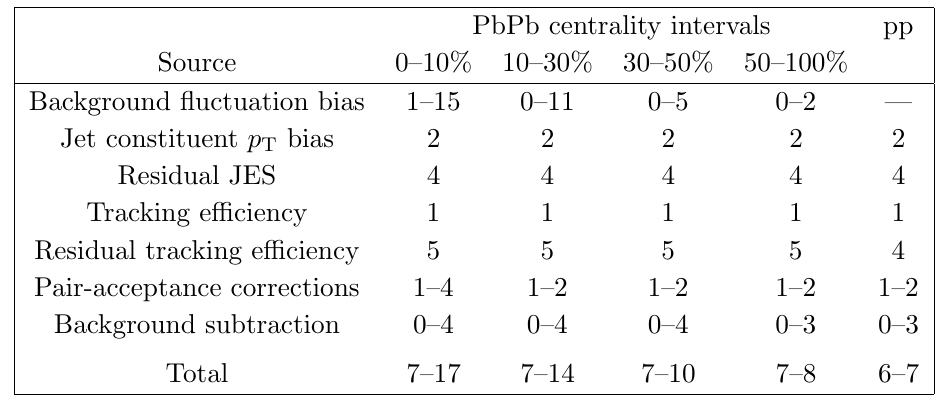
Table 1 . Systematic uncertainties in percentage for the measurements of the jet-track correlations in PbPb and pp events. The PbPb results are given in intervals of centrality. Where an uncertainty range is given, the upper edge of the range corresponds to the bin with the smallest p trk